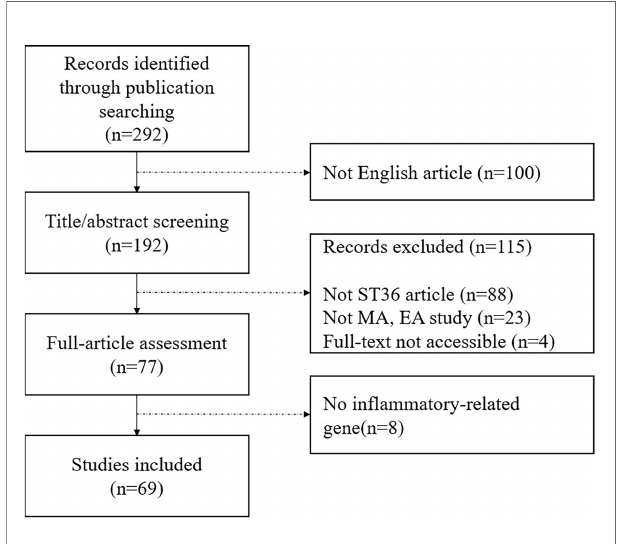
FIGURE 1 | Flowchart of study